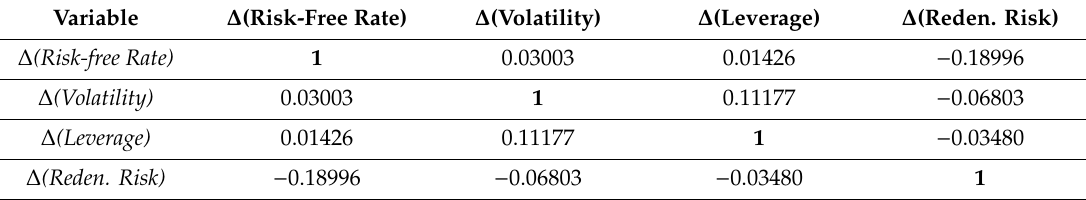
Table A6. Correlation matrix: period October 2009–July 2012 (723 Obs.).